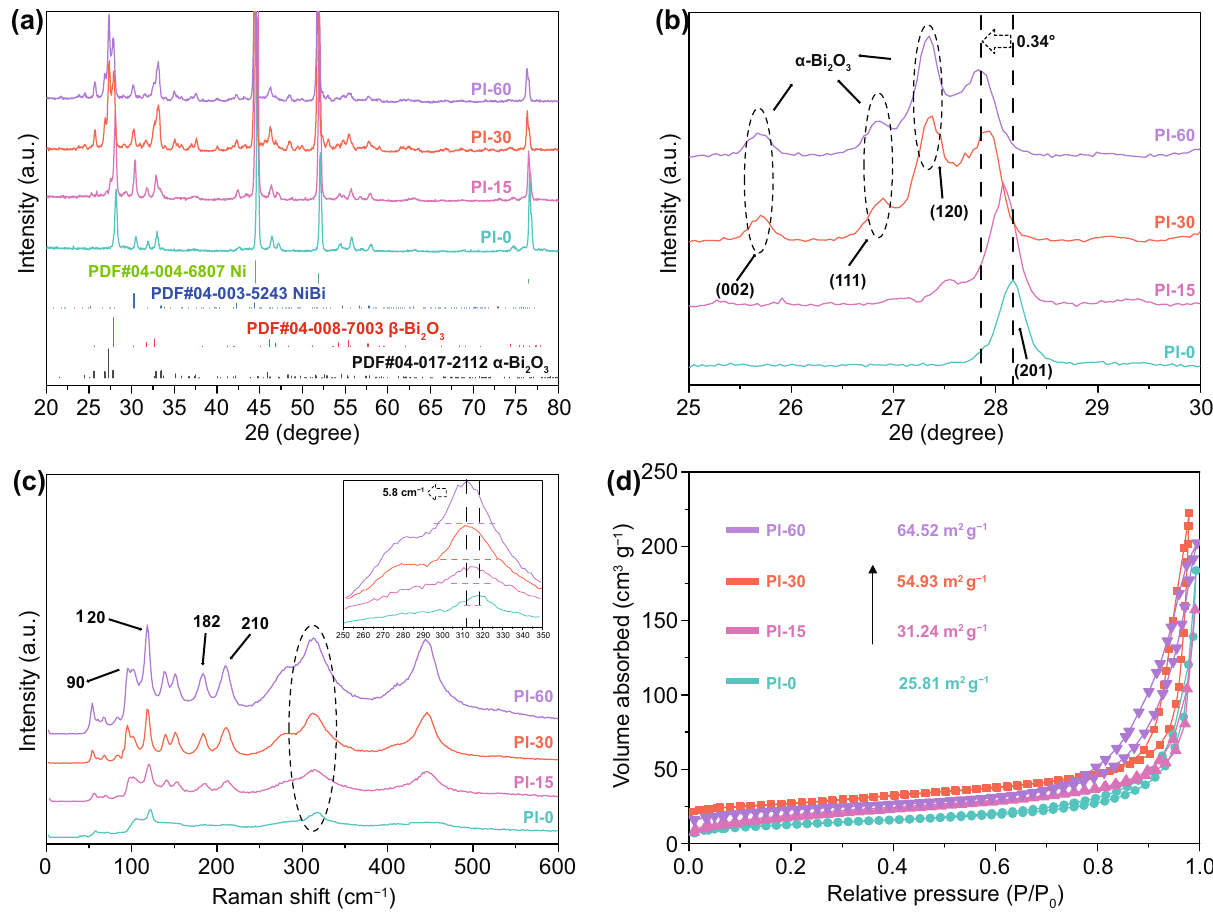
Fig. 3 Phase evolution of 2D Bi 2 O 3 nanosheets upon plasma irradiations. XRD spectrum ( a ), locally enlarged image of XRD patterns ( b ), Raman spectrum with the inset showing the peak shifting and broadening ( c ), and N 2 adsorption and desorption spectrum ( d ) of samples Pl-0, Pl-15, Pl-30, and